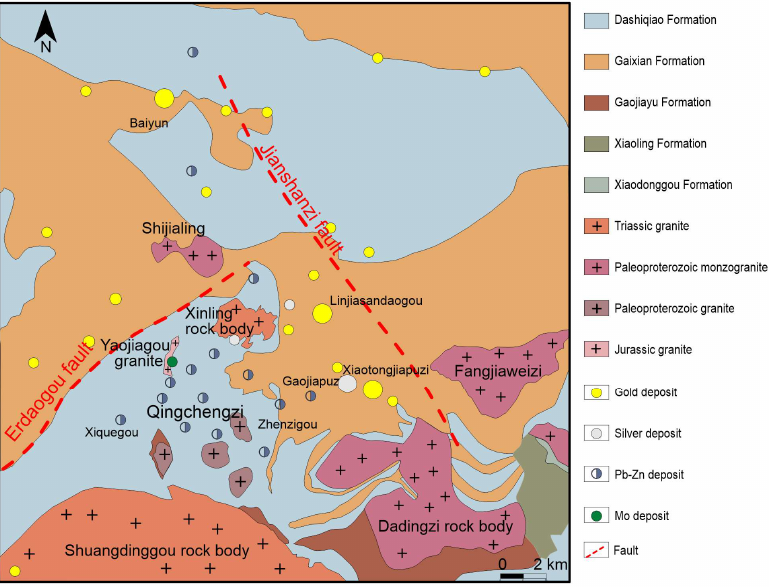
Figure 2. Geological map of the Qingchengzi orefield (modified after Zeng et al. [47] ).